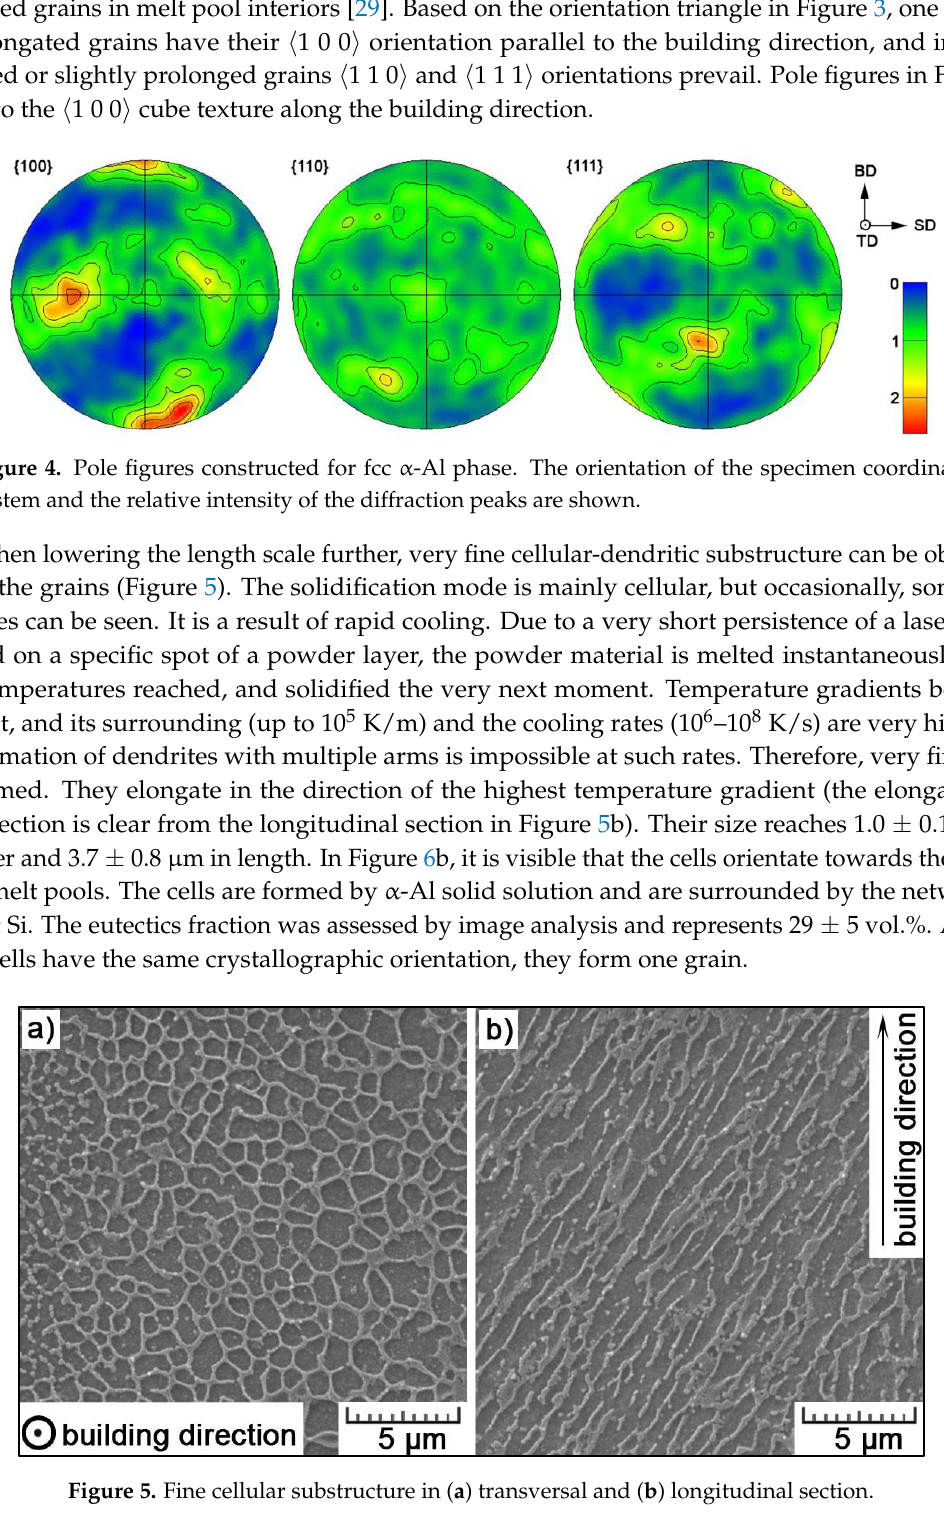
Figure 6. Melt pool boundaries in ( a ) transversal and ( b ) longitudinal section (arrows show the directionality of cells towards the melt pool center). SEM images in Figure 6 show the boundaries of ‘melt pools’, about 10–15 µm thick. Here, the cellular substructure is coarser, what can be explained by the Gauss distribution of laser energy. The undercooling changes over the melt track; it reaches the maximum at the centerline, then gradually decreases and goes to the minimum at the boundary of the melt track [33]. From this point of view, the cellular size attains the minimum at the center of the melt track, while it reaches the maximum value on its boundary. The greatest details are provided by TEM images in Figure 7. It can already be distinguished that the cell boundaries are formed by a network of silicon particles. These particles are cubic with an edge length of 30–70 nm. A significantly higher density of Si particles can be observed within the interior of melt pools (Figure 7b). Such a difference can be explained by a different thermal history. With higher undercooling inside melt pools, more numerous, and finer particles are formed [34].